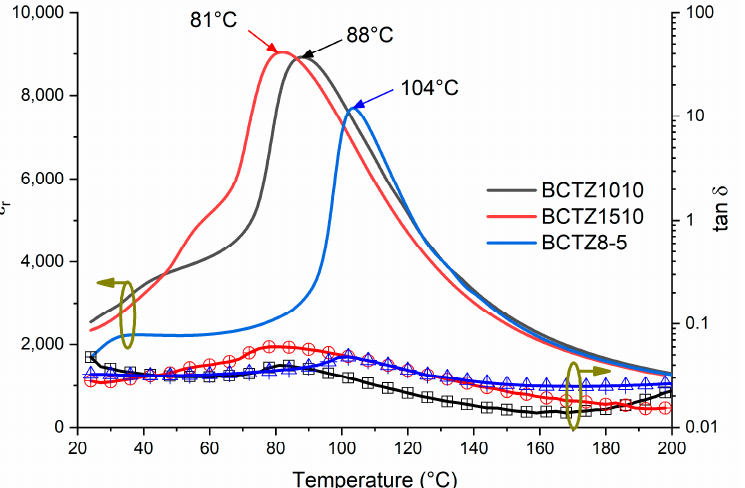
Figure 3. A comparison of the dielectric permittivity and losses of BCTZ8-5 against another two important BCTZ compositions: Ba 0.85 Ca 0.15 Ti 0.90 Zr 0.10 O 3 (BCTZ1510) and Ba 0.90 Ca 0.10 Ti 0.90 Zr 0.10 O 3 (BCTZ1010) calculated at 1 kHz.